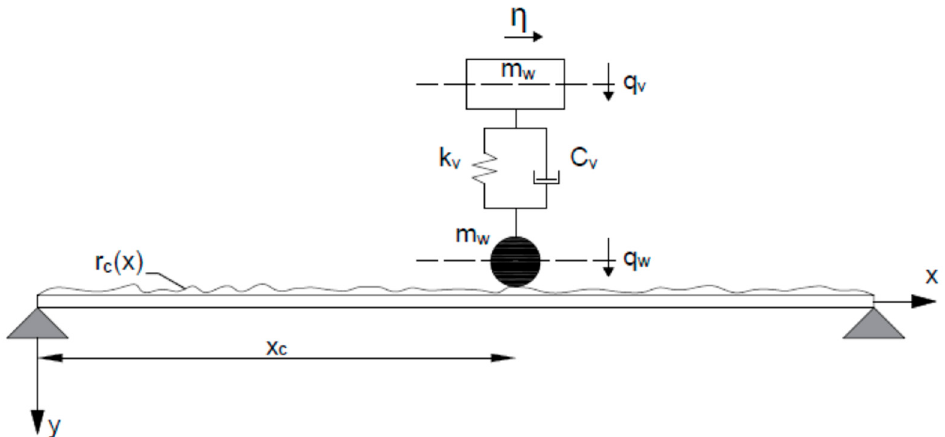
Figure 1. Sprung mass model of a car moving on a bridge.